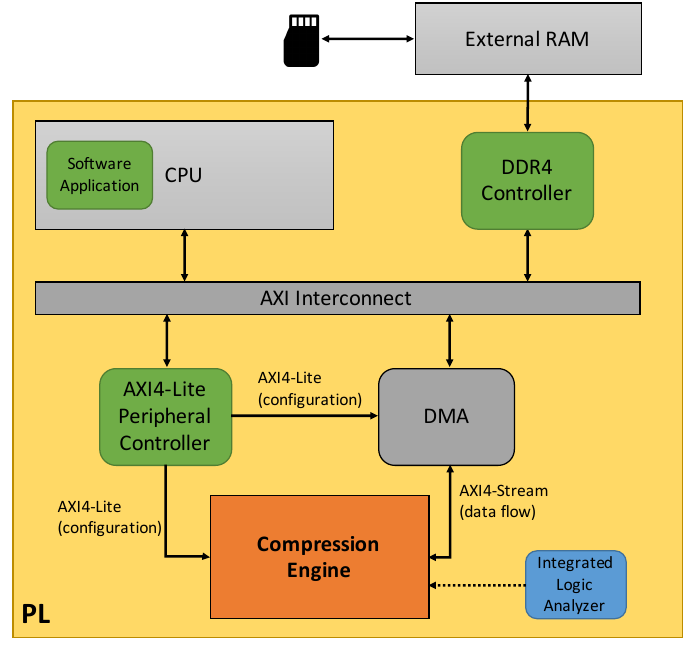
Figure 6. Validation